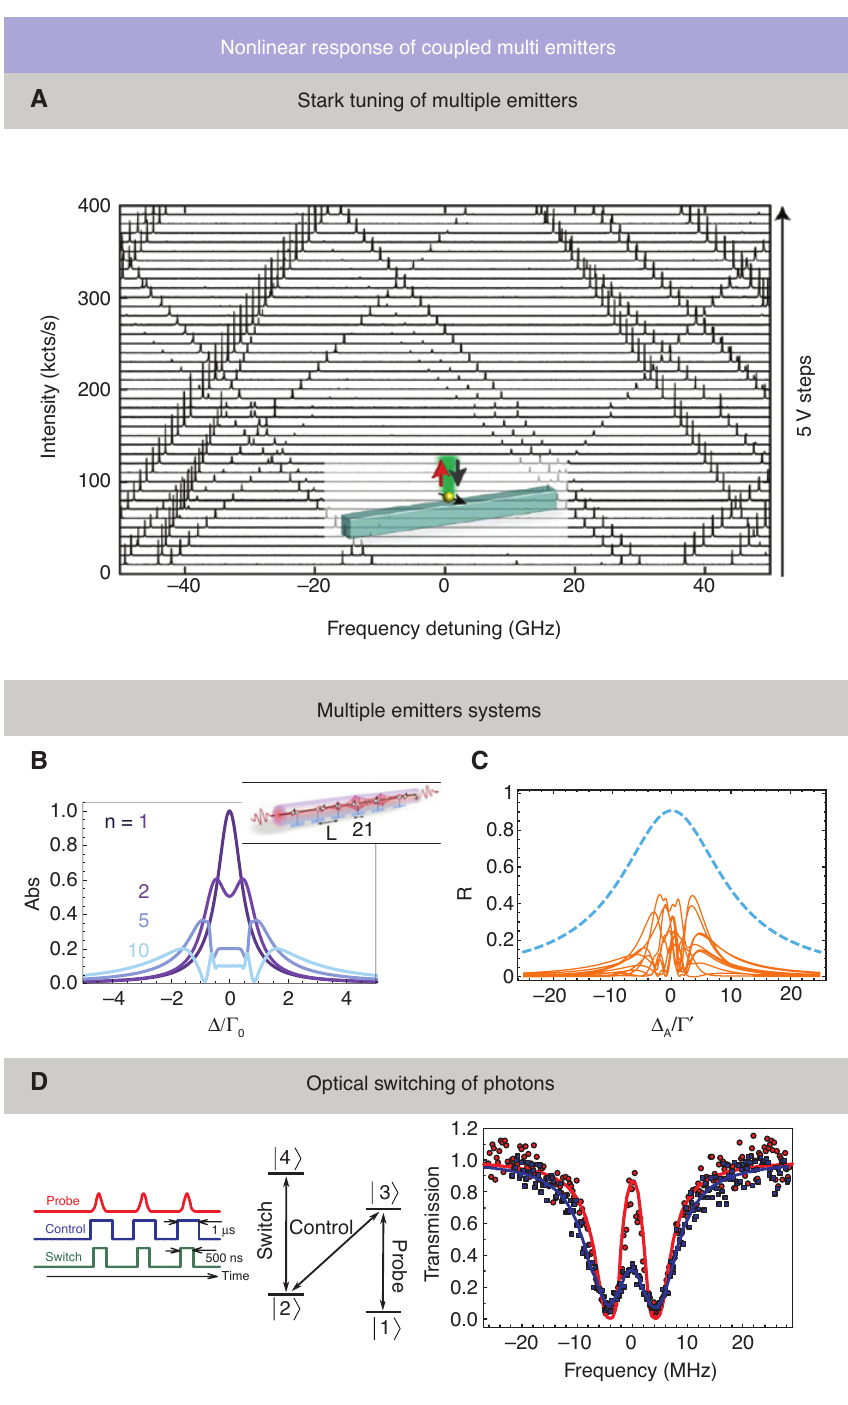
Figure 7: (A) Stark tuning of many organic molecules found within a single confocal excitation spot, as shown in the inset. Spectra taken at different Stark voltages demonstrate that it is possible to tune multiple emitters into resonance with one another on a photonic chip. Adapted from [120]. (B) Absorption spectrum calculated for a chain of well-coupled N emitters ( β = 0.99) arranged at arbitrary positions about a regular lattice spaceing L = 2.75 in a nanoguide (see inset). As the number of emitters increases (dark to light hues), normal-mode splitting is observed, while for N = 10 narrow peaks near zero detuning Δ = 0 emerge because of the presence of subradiant modes. Adapted from [59]. (C) Reflection spectra for 20 atoms interacting through the guided modes of an unstructured waveguide. The dashed blue line represents a regular separation between the atoms of λ /2. The orange curves show 10 different spectra obtained by randomly placing the atoms along the nanostructure. Adapted from [60]. (D) Nonlinear optical switch based on four-level emitters coupled to a fiber. The timing sequence for the probe, control, and switch fields (right) and the corresponding level scheme of the emitters (center). Left: In the absence of the switch field, the probe field is largely transmitted through the fiber (red data). A strong suppression of the transmission is observed when the switch field is on (blue data). Adapted from